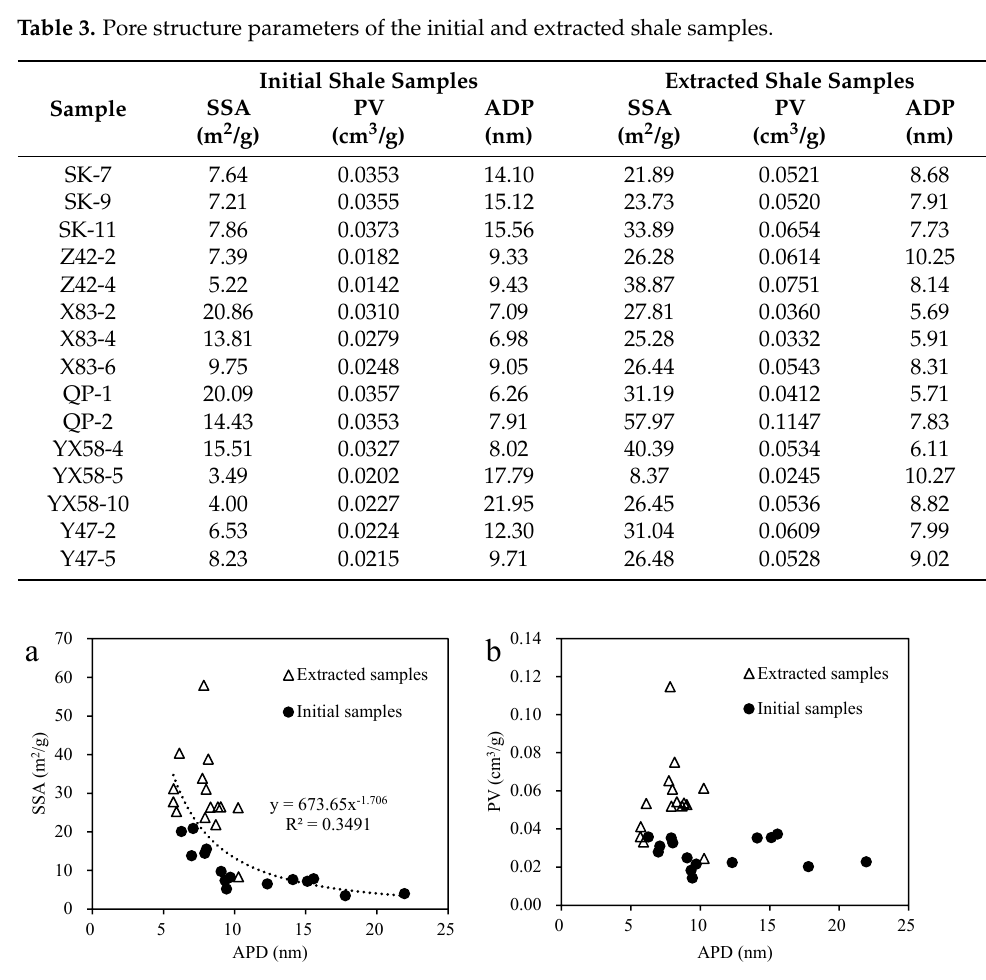
Figure 6. Correlation between the average pore diameter (APD) and ( a ) specific surface area (SSA) and ( b ) pore volume (PV).